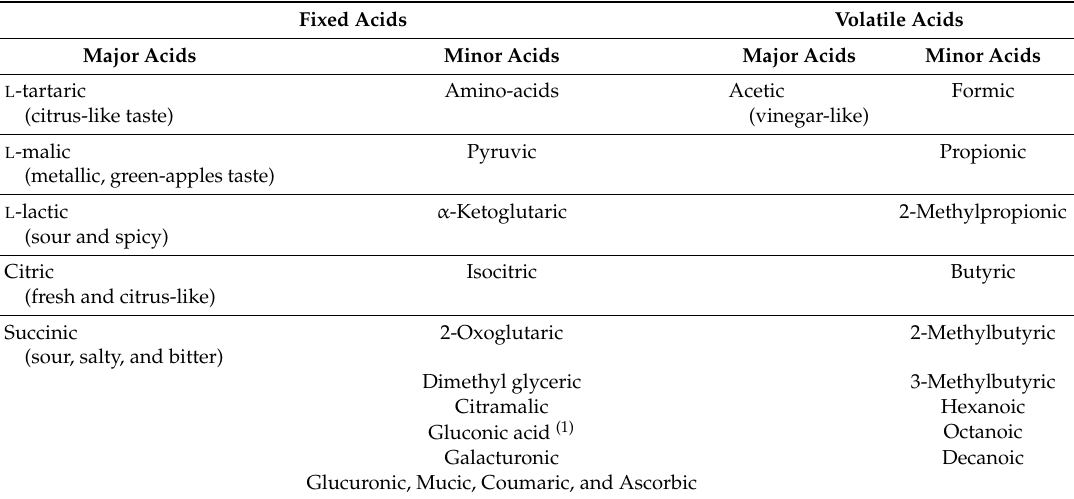
Table 1. Organic acids present in grapes and wines and major acids’ sensory descriptors. Adapted from Boulton et al.